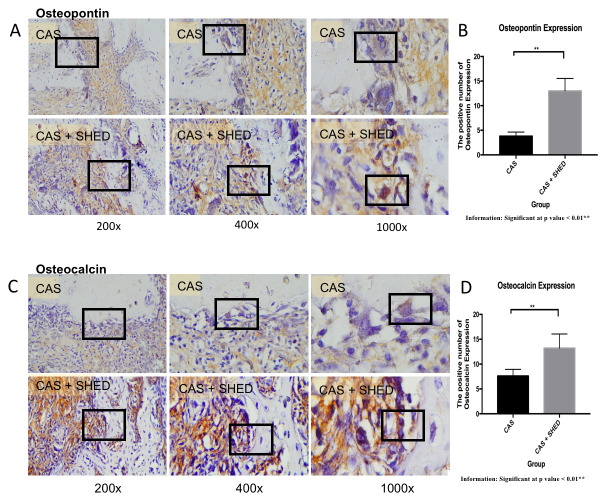
Histological sections of the Wistar rat’s (
R. Novergicus) afflicted periodontal tissues.Immunohistochemistry with antibody monoclonal (AbMo) and DAB were performed to examine the (
A) osteocalcin and (
B) osteopontin expressions. Positive cells were stained brown (black box) in 200x, 400x, 1000x magnification by using the light microscope. The number of osteoblasts expressing (
C) osteocalcin and (
D) osteopontin in the alveolar bone of the rats.